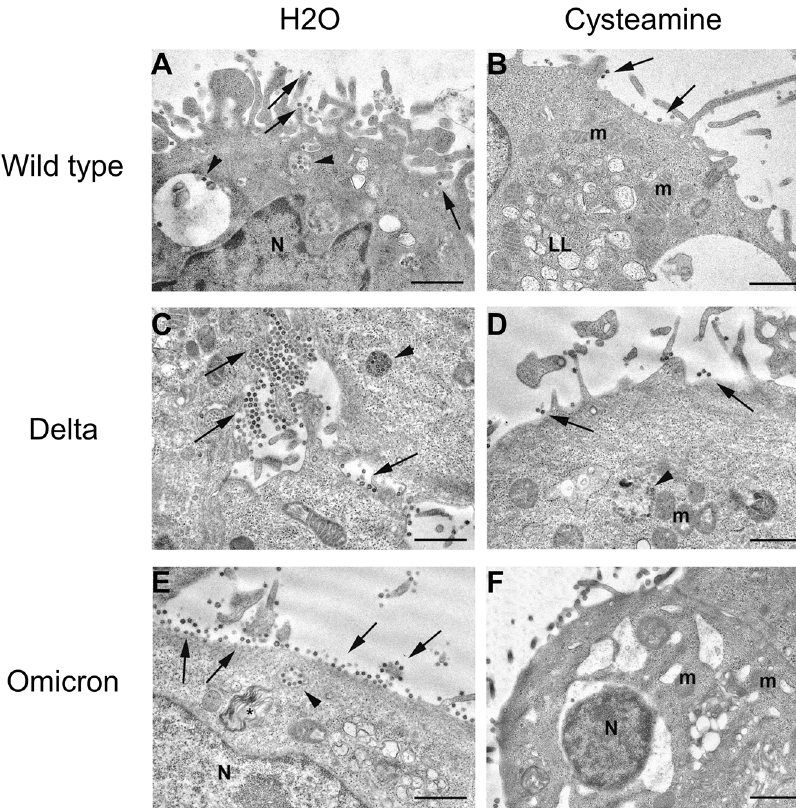
Fig. 3 Electron microscopy images of Vero E6 cells infected with SARS-CoV-2 variants. Representative electron micrographs of Vero E6 cells at 48 h.p.i. with different SARS-CoV-2 variants, in the absence ( A , C , E ) or in the presence ( B , D , F ) of cysteamine treatment. Cells infected with Wild type ( A ), Delta ( C ), and Omicron ( E ) display similar fi ndings: numerous viral particles are visible attached to the cell surface (arrows) and inside membrane-bound vesicles in the cytoplasm (arrowheads). Vacuoles are present in the cytoplasm, many of them consisting in lipolysosomes (LL), and convoluted membranes vesicles (*). Cysteamine treatment completely blocks the infection with Omicron ( F ), while part of Wild type ( B ) and Delta ( D ) treated cells show the presence of viral particles, although reduced in number compared with the untreated cells. N nucleus, m mitochondria. Scale bars: 1 µm.